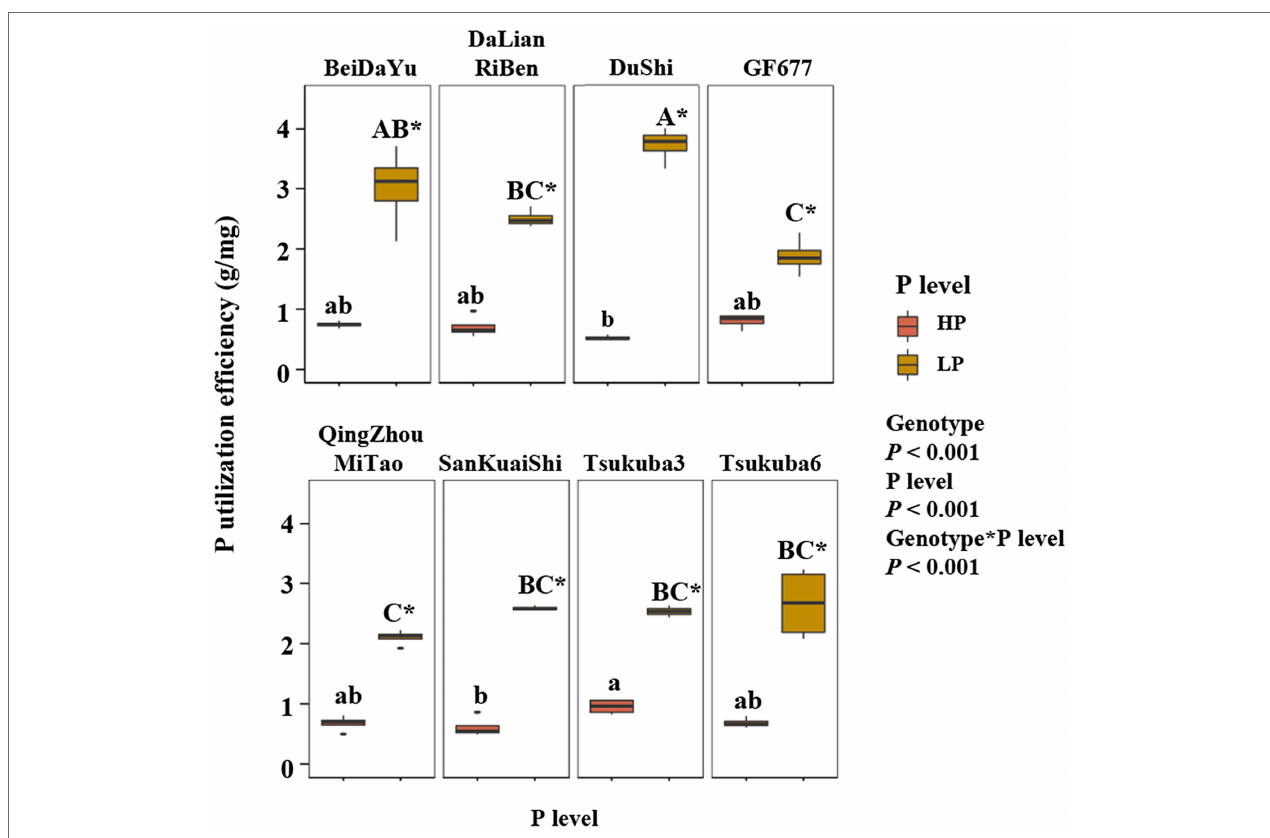
FIGURE 2 | Phosphorus (P) utilization efficiency (PUE) of eight peach rootstocks under HP and LP. The statistical results are of two-way ANOVA testing for the effects of genotype and P level on PUE. Different lower- and upper-case letters indicate significantly differences ( p < 0.05) in PUE of eight peach rootstocks under HP and LP, respectively. * indicates significantly effects of the same peach rootstock species under two levels of phosphorus supply at p < 0.05